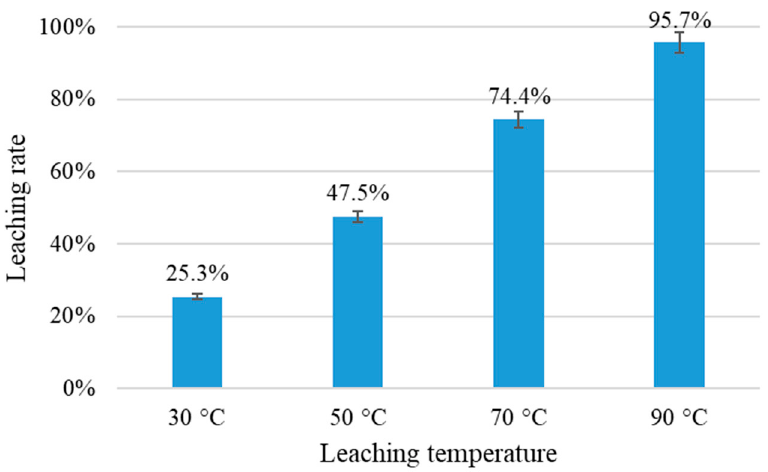
Figure 6. Leaching rates of Pt at different leaching temperature (HCl 1.0 mol/L, NaCl 5.0 mol/L, S/L = 1:5, 10% H 2 O 2 : spent catalysts = 0.6 mL/g).